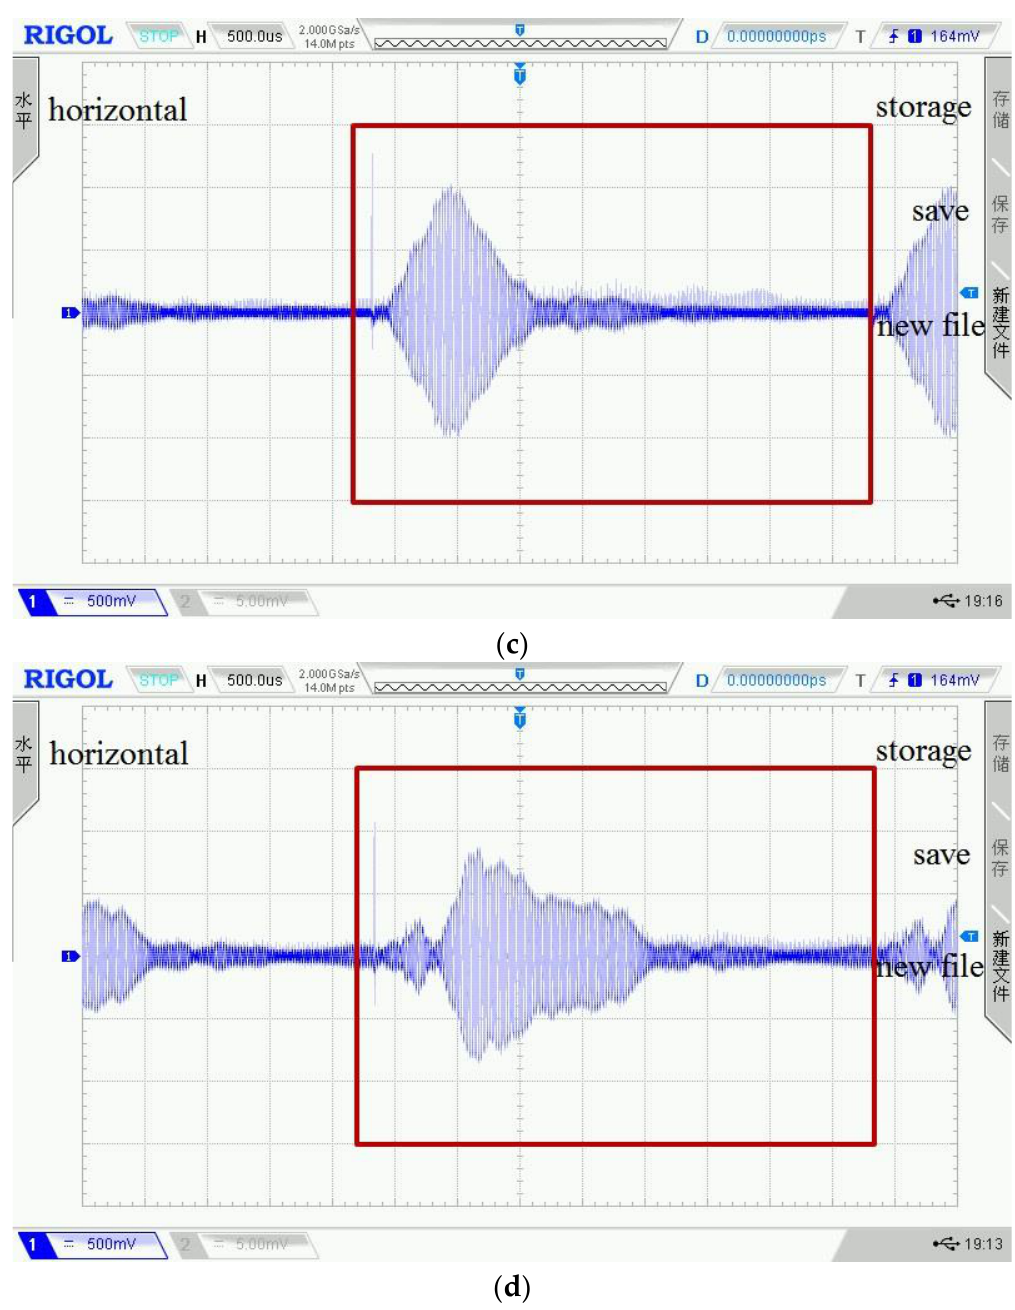
Figure 11. ( a ) No defect detection waveform; ( b ) Hole detection waveform; ( c ) Crack detection waveform; ( d ) Foreign matter detection waveform.